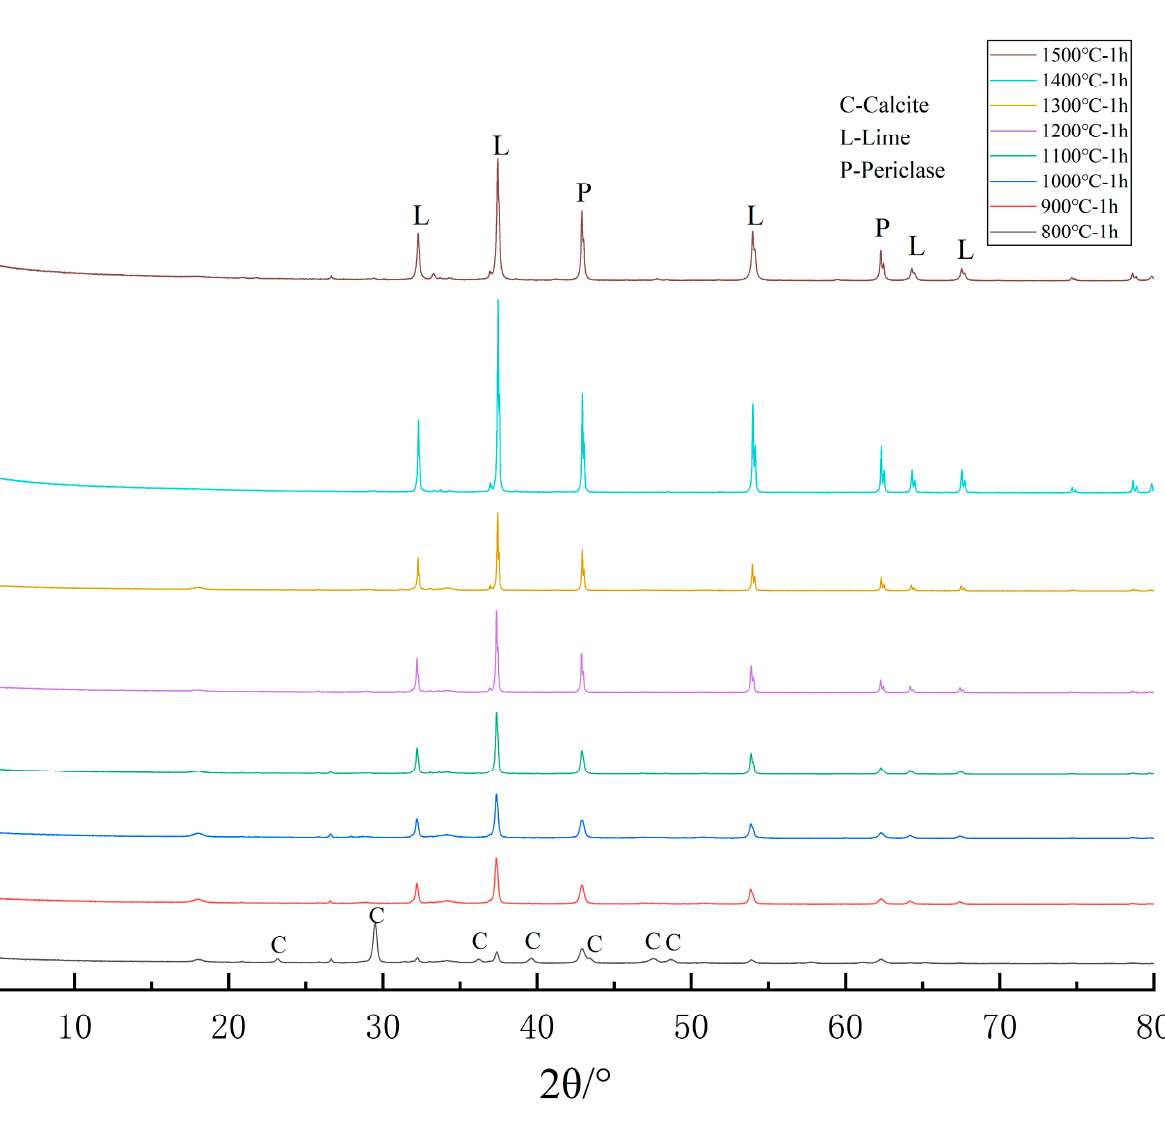
Figure 1. XRD pattern of calcined products of dolomite.